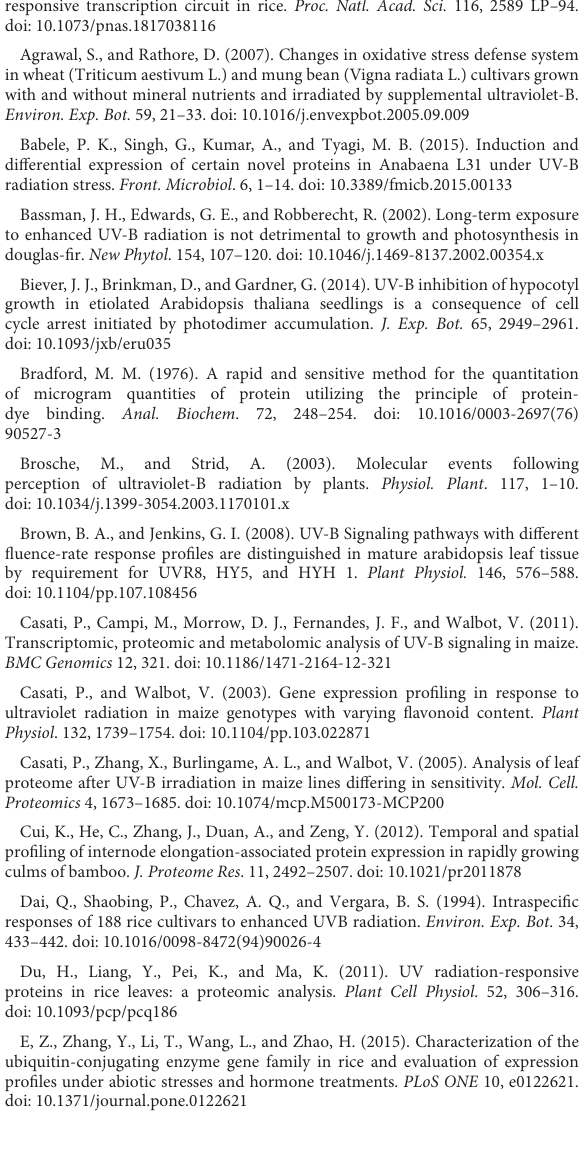
SUPPLEMENTARYFIGURE1 Schematic illustration of the layout of